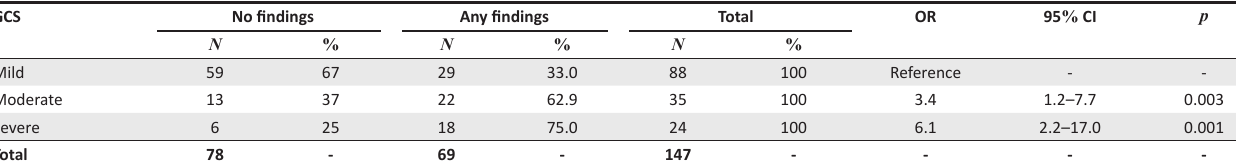
TABLE 2: Severity of brain